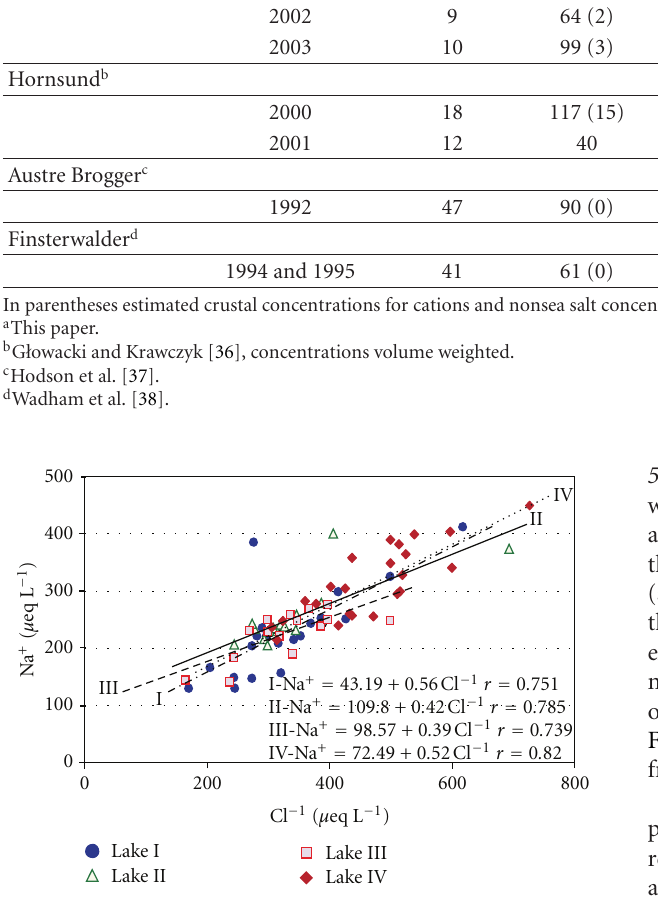
Figure 6: Relationships between concentration of Cl − and Na + with regression lines and equations for tundra